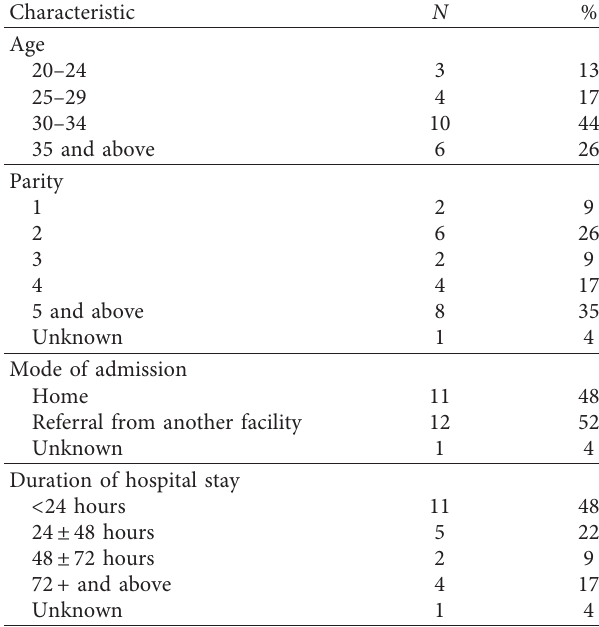
Table 2: Demographic characteristics, mode of admission, and du- ration of hospital stay of the deceased due to haemorrhage ( N � 23).